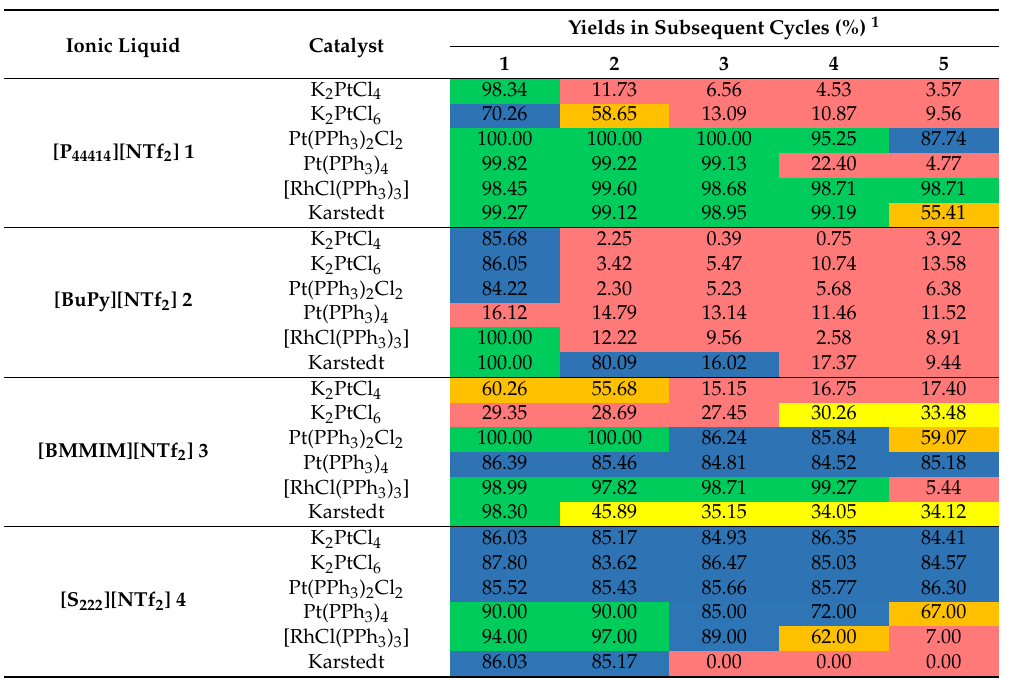
Table 1. Yields of hydrosilylation reaction in subsequent cycles for biphasic systems of ionic liquids and catalysts